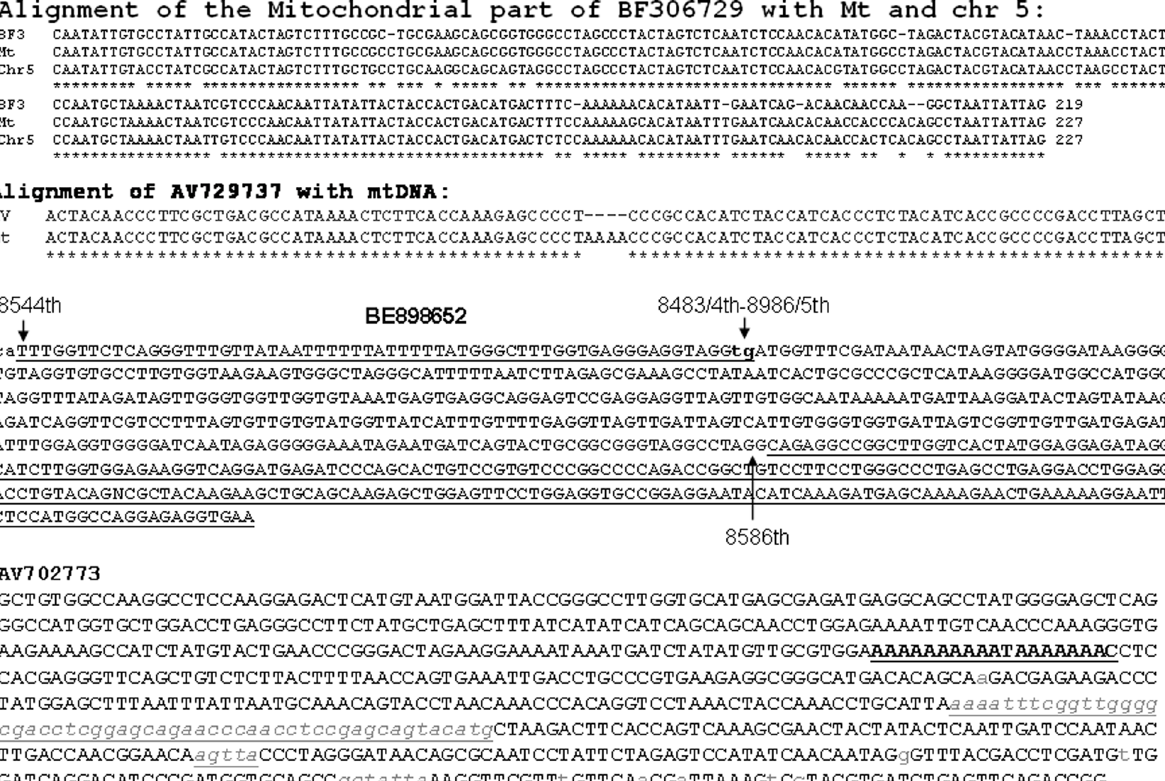
Table 4. ESTs that are mt-only sequences and are probably cis-spliced products.